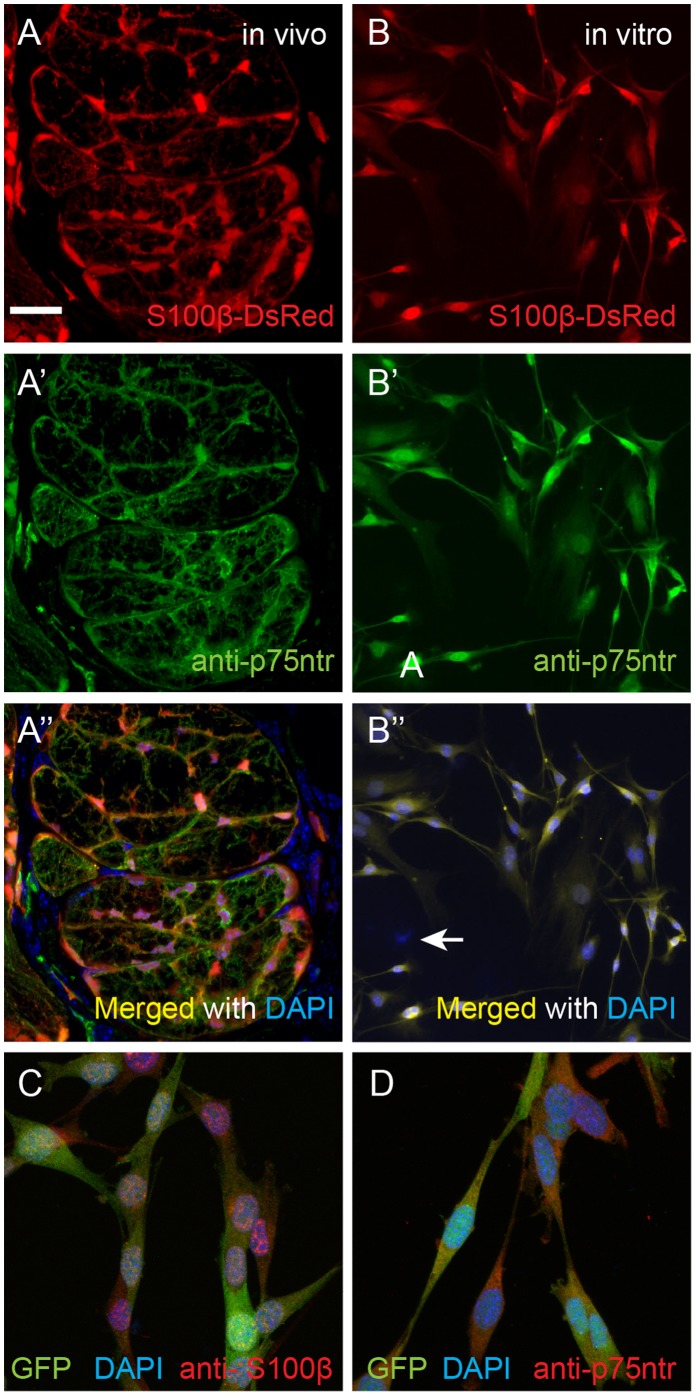
Immunofluorescence of OECs in vivo and in vitro.(A–A′′) A cross section through olfactory nerve bundles within the lamina propria of a postnatal day 7 mouse pup; OECs that surrounded and formed the nerve bundles expressed S100β-DsRed (A) and p75ntr (A′); the merged image together with nuclei stained with DAPI is shown in A′′. (B–B′′) In cultures of purified OECs, the OECs continued to express DsRed (B); 95% of DsRed OECs were positive for anti-p75ntr immunostaining (B′); the merged image is shown in B′′ together with nuclei which are stained with DAPI. Arrow in B′′ points to a cell that did not express DsRed or p75ntr. (C–D) Characterization of clonal cell line of mouse OECs expressing GFP. OECs were positive for anti-s100β (C) and anti-p75ntr (D). Scale bar = 50 µm in A–A′′, C–D; 100 µm in B–B′′.